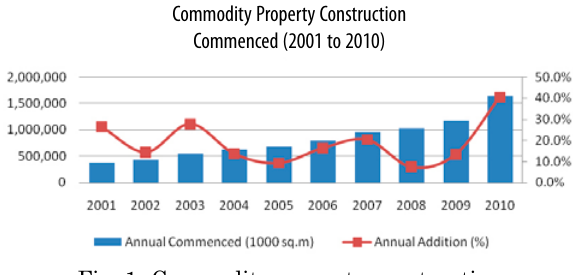
Fig. 1. Commodity property